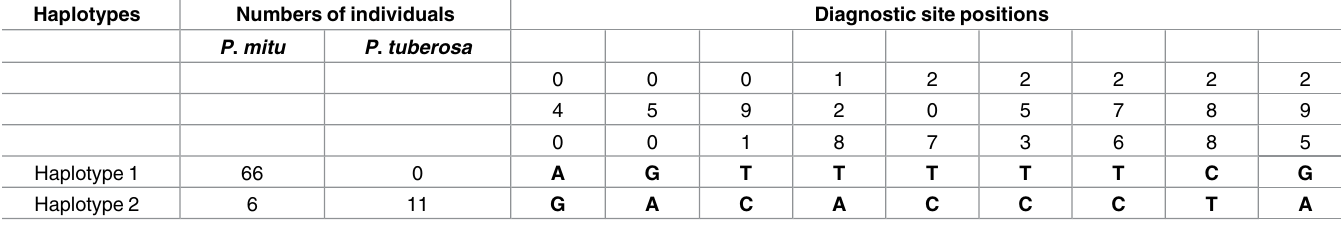
Table 2. Numbers of Razor-billed Curassows ( Pauxi tuberosa ), and of animals assigned to the Alagoas Curassow ( P . mitu ) based on morphology and microsatellite analyses,presenting each of two mtDNA control region haplotypes. Vertical numbers correspond to positionsin the